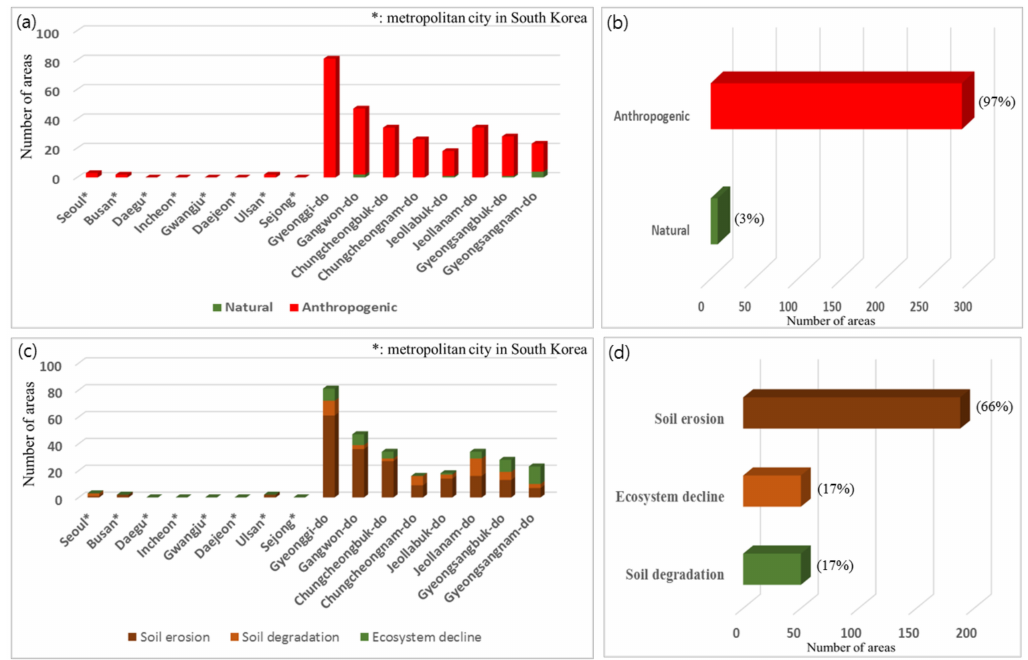
Figure 7. Distribution status of damaged areas in South Korea by cause and type: ( a ) Distribution of damaged areas by cause for each regional local government and; ( b ) total distribution of damaged areas by cause in South Korea; ( c ) Distribution of damaged areas by type for each regional local government and; ( d ) total distribution of damaged areas by type in South Korea.